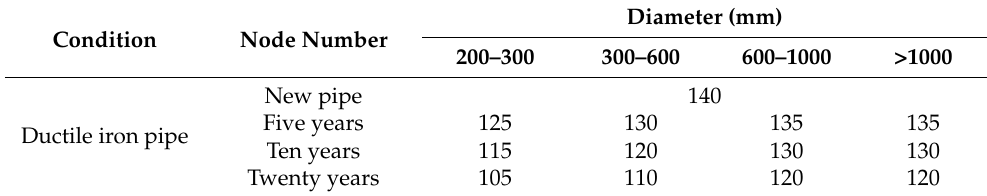
Figure 1. Study area: ( a ) GIS map; ( b ) the established EPANET model. Table 1. Initial values of the pipe roughness coefficient